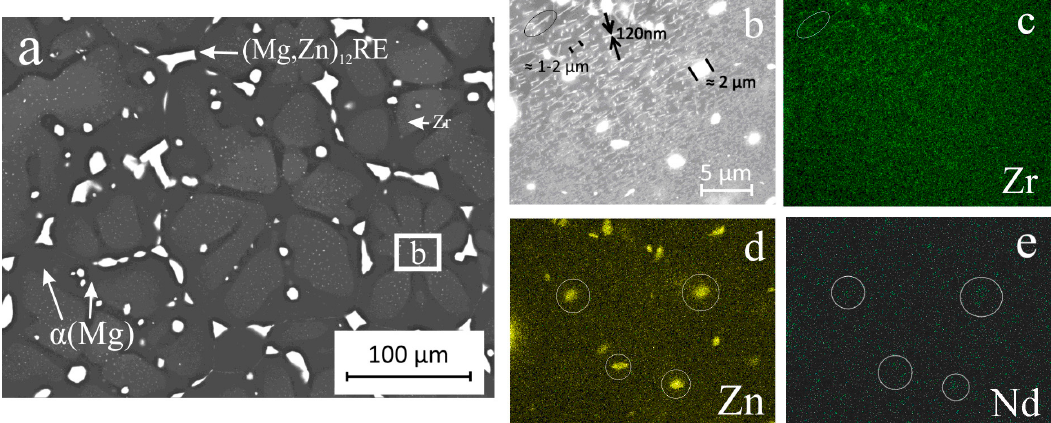
Figure 3. SEM results obtained for Mg-alloy EZ33A after annealing at 150 °C for 1826 h. ( a ) Overall SEM back scatter micrograph. ( b ) SEM back scatter micrograph of the grain interior taken at a higher magnification. Sizes, shapes, and distances between precipitates can be appreciated. Energy-dispersive X-ray spectroscopy (EDX) element distribution maps from microstructural region shown in Figure 3b: ( c ) Zr, ( d ) Zn, and ( e ) Nd.